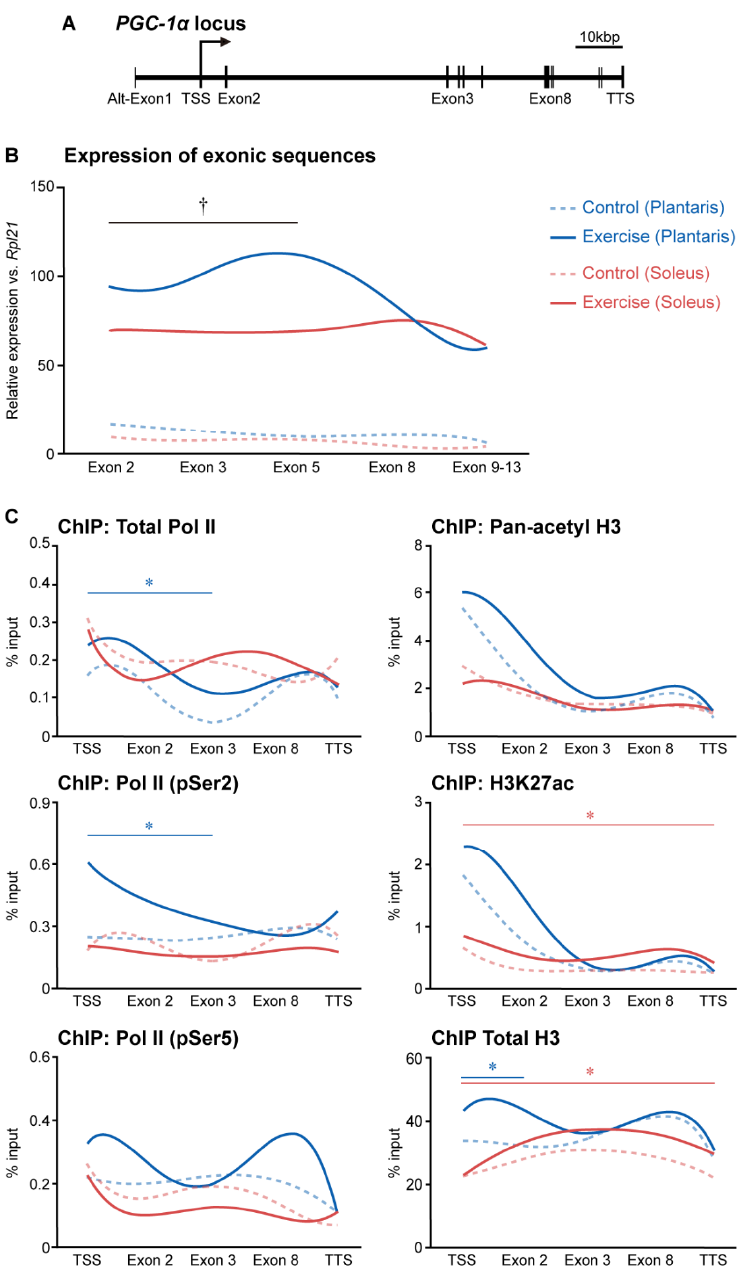
Figure 2. Different response of PGC-1α gene expression to exercise in rat plantaris and soleus muscles. ( A ) Rat PGC-1α locus showing the position of exons targeted for analysis. ( B ) Differential upregulation of exonic sequences between the plantaris (blue) and soleus (red) muscles. Note that the expression of proximal sequences was more enhanced in the plantaris muscle, indicating higher transcriptional activity than soleus muscle. †: p < 0.05 in the plantaris vs. soleus muscles after exercise. ( C ) Distribution of RNA polymerase II (Pol II) and histone modifications analyzed by ChIP-qPCR, and their changes in response to exercise. Note that the accumulation of Pol II in response to exercise was significantly induced at the proximal sequences in the plantaris muscle, in which histone acetylation was prevalent. *: p < 0.05 in control vs. after exercise in the plantaris (blue) or soleus (red) muscles. The maximum length of the continuous regions from the TSS was selected by one-way ANOVA ( B , C ). The data were obtained from Masuzawa et al. [22] and com- bined between plantaris and soleus muscles.